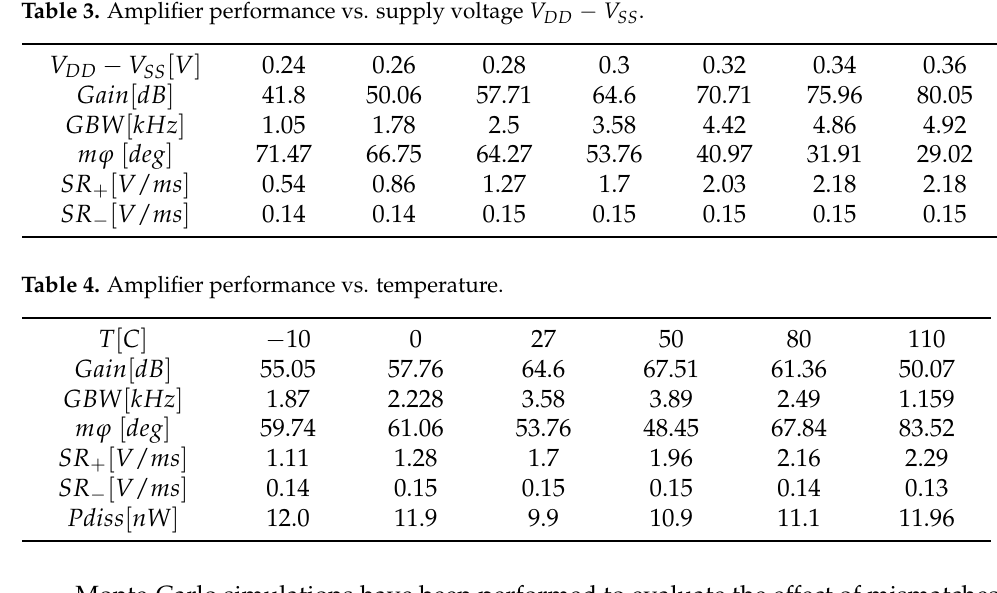
Table 3. Amplifier performance vs. supply voltage V DD